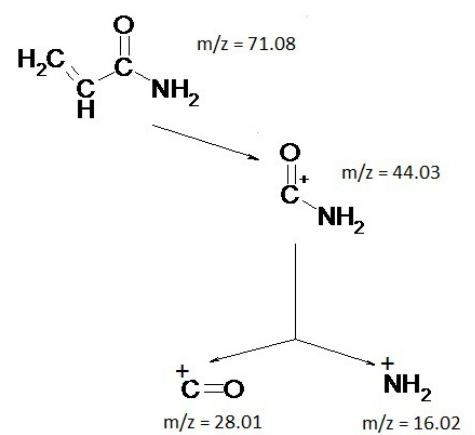
Figure 5. Acrylamide fragmentation